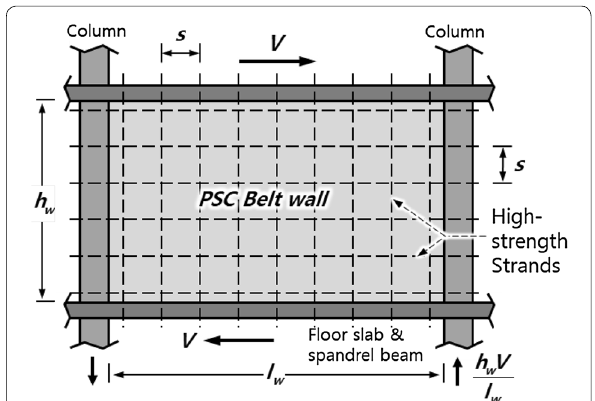
Fig. 8 Prestressed belt wall